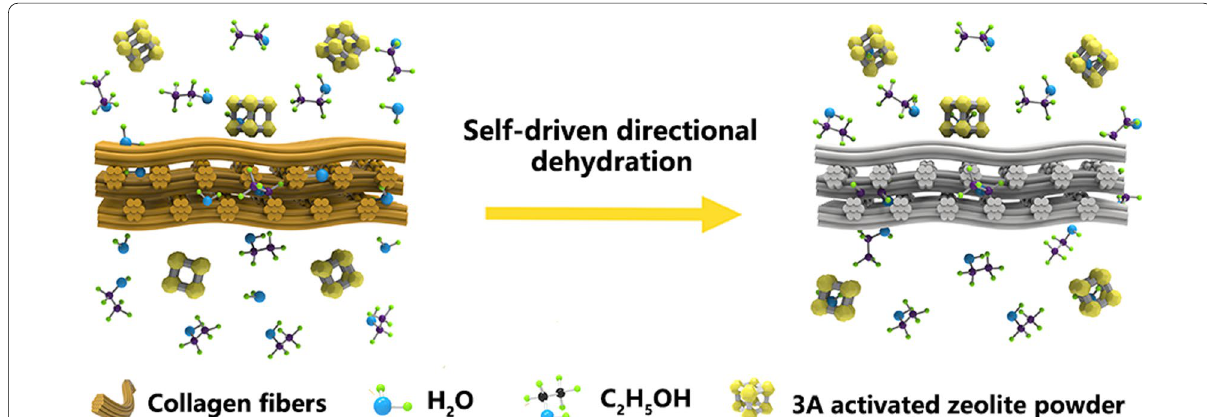
Fig. 1 Schematic illustration showing the self-driven directional dehydration of raw hide by the SDD composite media comprised of anhydrous ethanol and 3A activated zeolite